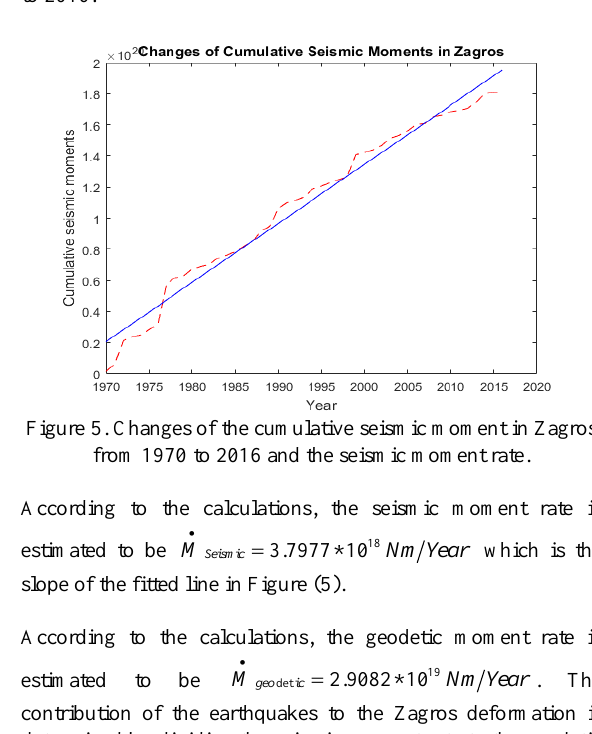
Figure 4. Changes of the seismic moment in Zagros from 1970 to 2016 The cumulative seismic moment in each year is calculated using the seismic moments of previous years. Figure (5) depicts the changes of the cumulative seismic moment in Zagros from 1970 to 2016.